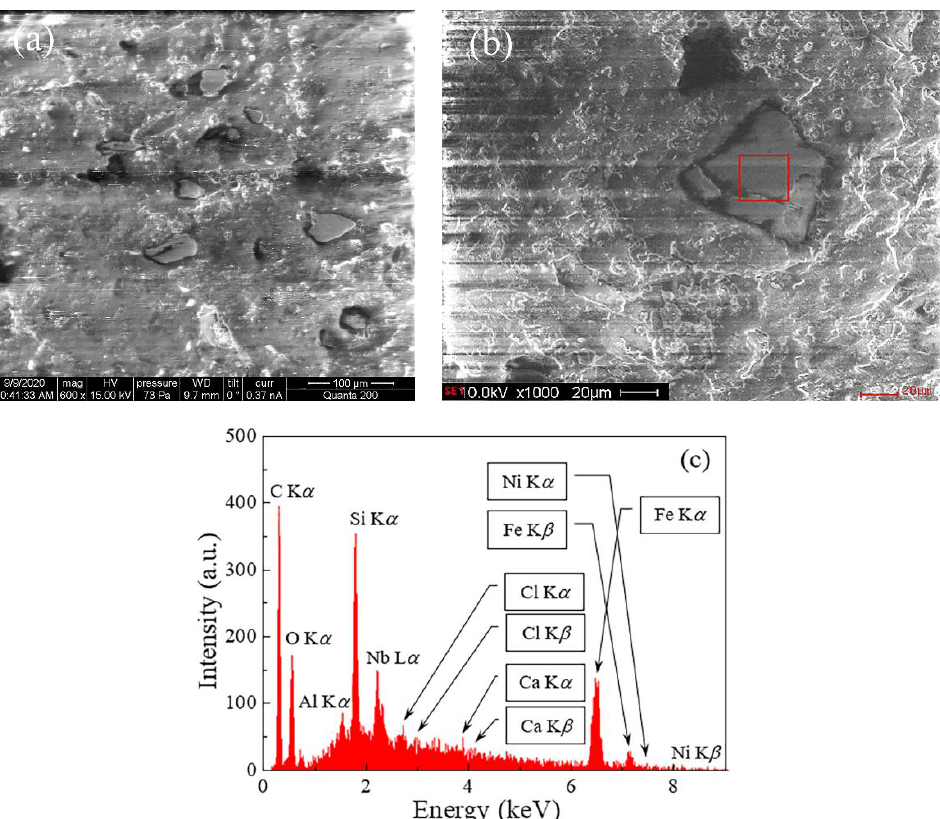
Figure 1. The distribution of flake radii ( a ); the X-ray diffraction image of the composite medium for a sample with 15% particles ( b ).